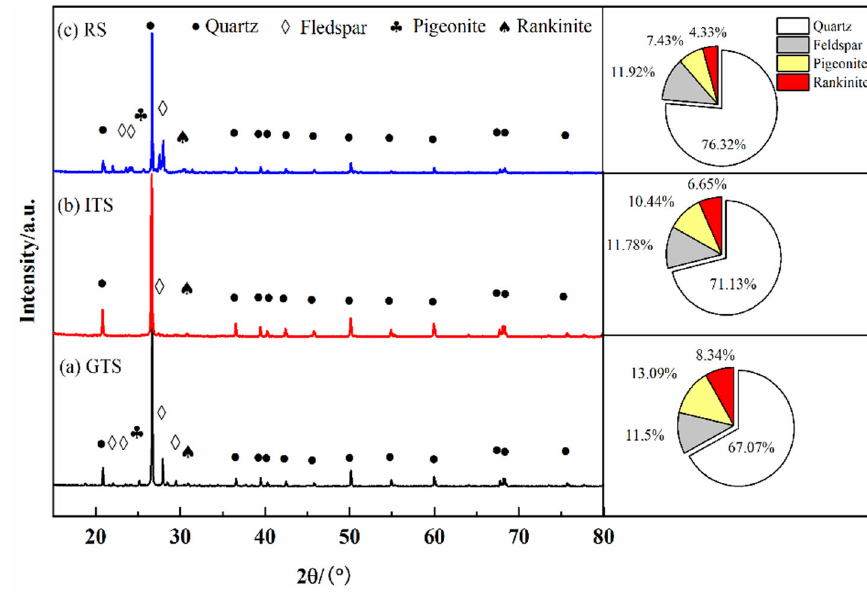
Figure 3. Mineral component and content of aggregate ( a ) GTS, ( b ) ITS and ( c ) RS . Table 2. Chemical composition of fine